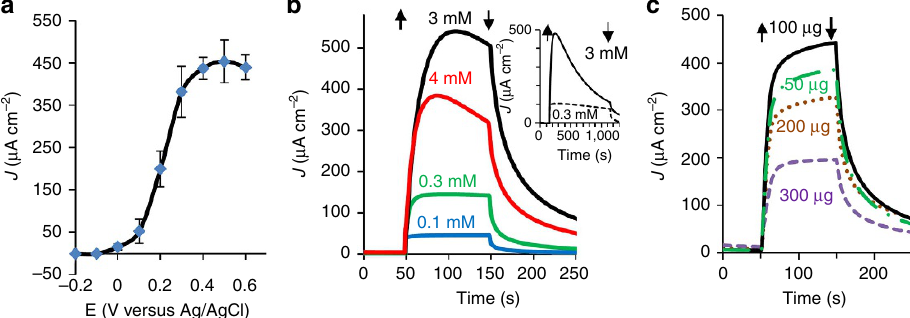
Figure 2 | Photocurrent measurements in three-electrode mode. ( a ) Photocurrent density as a function of the electrode potential, measured in buffer A solution with a thylakoid content of 0.1mgChl and Fe(III)CN concentration of 3mM. The error bars represent the s.d. over four independent measurements. ( b ) The photocurrent, measured at an electrode potential of 0.5V Ag/AgCl , as a function of time during exposure to solar-simulated light between t ¼ 50 and 150s. Four measurements in buffer A solution with a thylakoid content of 0.1mgChl and Fe(III)CN concentrations of 0.1, 0.3, 3 and 4mM are presented (blue, green, black and red curves, respectively). The inset shows the long-term photocurrent stability in high (3mM, full line) and low (0.3mM, dashed line) Fe(III)CN concentrations. The arrows indicate light turn on (up) and off (down) points. ( c ) The photocurrent dependence on the amount of thylakoids (expressed in mgChl) in solution. Maximal photocurrent was obtained with 100 m gChl (black line), whereas 50, 200 or 300 m gChl (green broken, brown dotted or purple dashed lines, respectively) yielded lower currents. The measurements were carried out in buffer A solution with 3mM